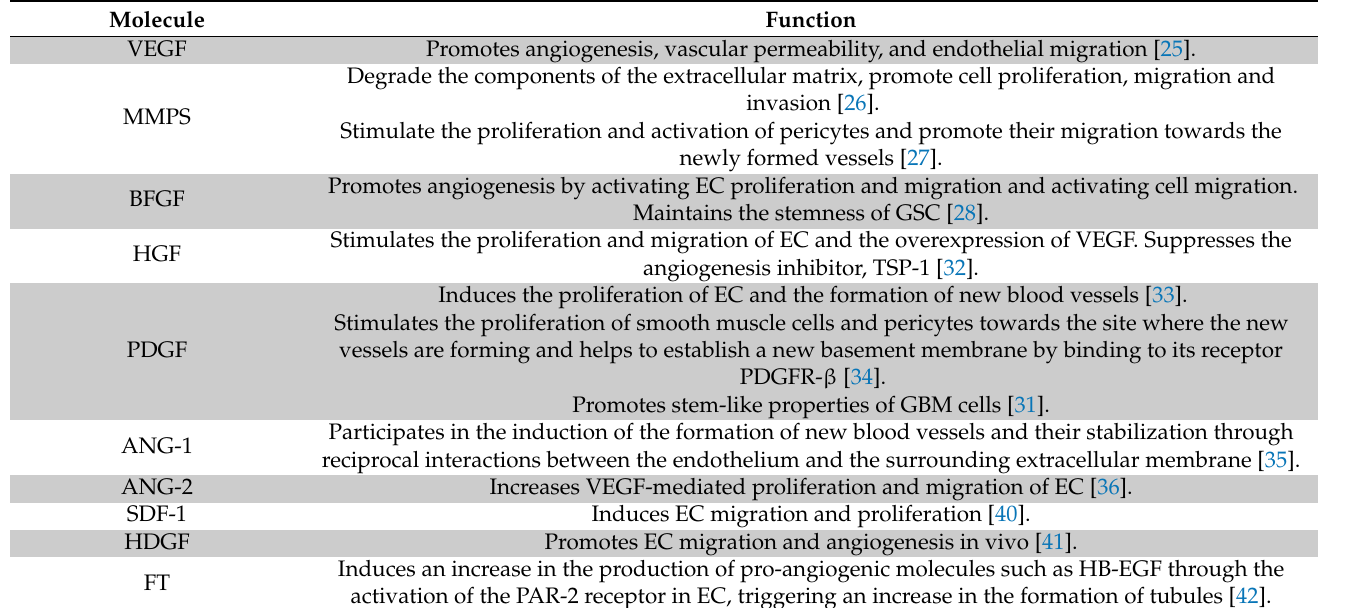
Table 1. Participation of classical angiogenic molecules in